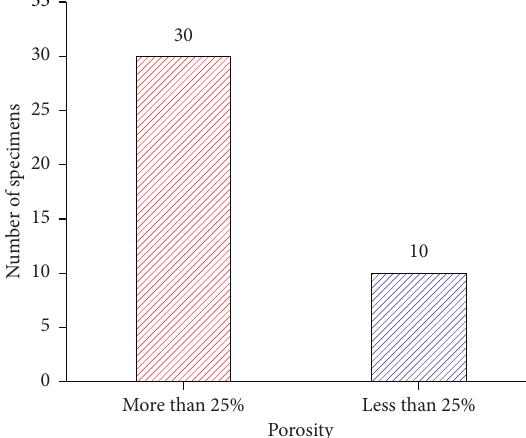
Figure 12: Distribution of undistributed soil specimens under different porosity.